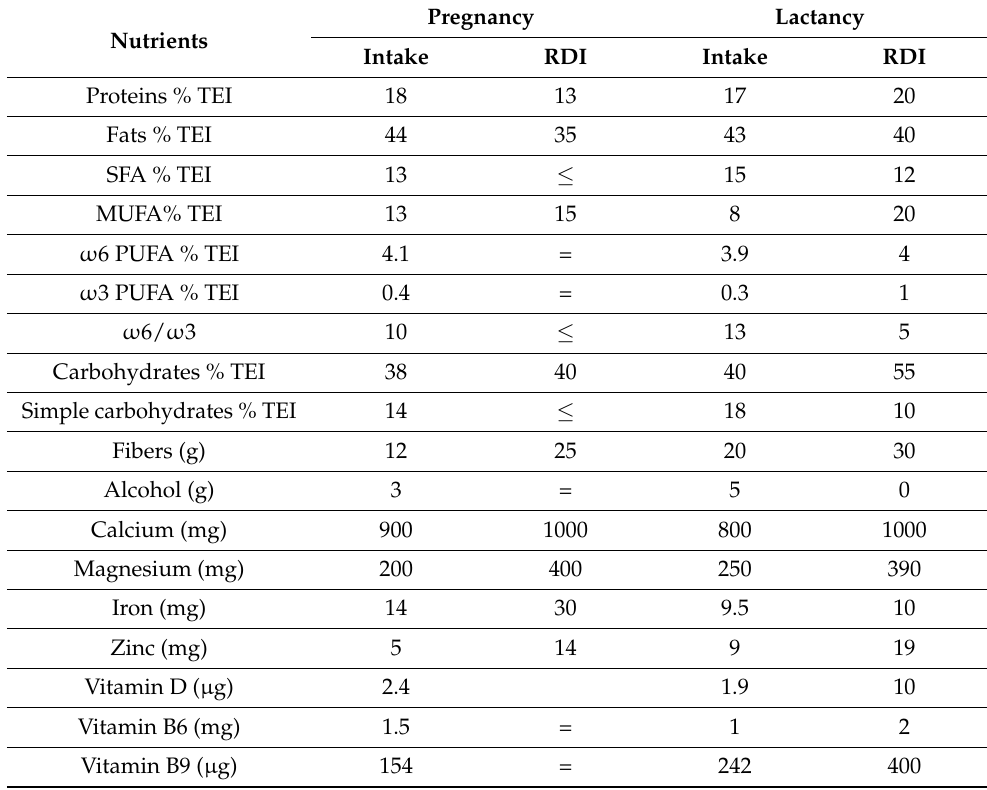
Table 7. Pregnancy and lactation recommended nutriments. ANSES. 2019 [23].